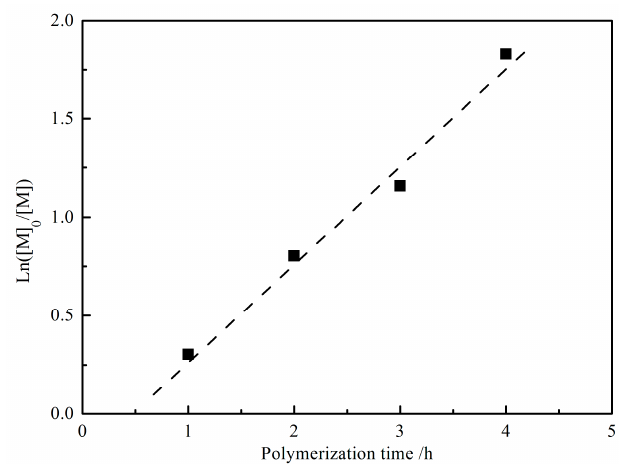
Figure 1. Pseudo-first-order kinetic plot of PNIPA RAFT polymerization. The polymerization condition is as follows: [NIPA]/[star-CTA]/[AIBN] = 167/1/0.2, the monomer concentration in THF is 25 wt %, polymerization temperature is 70 °C.